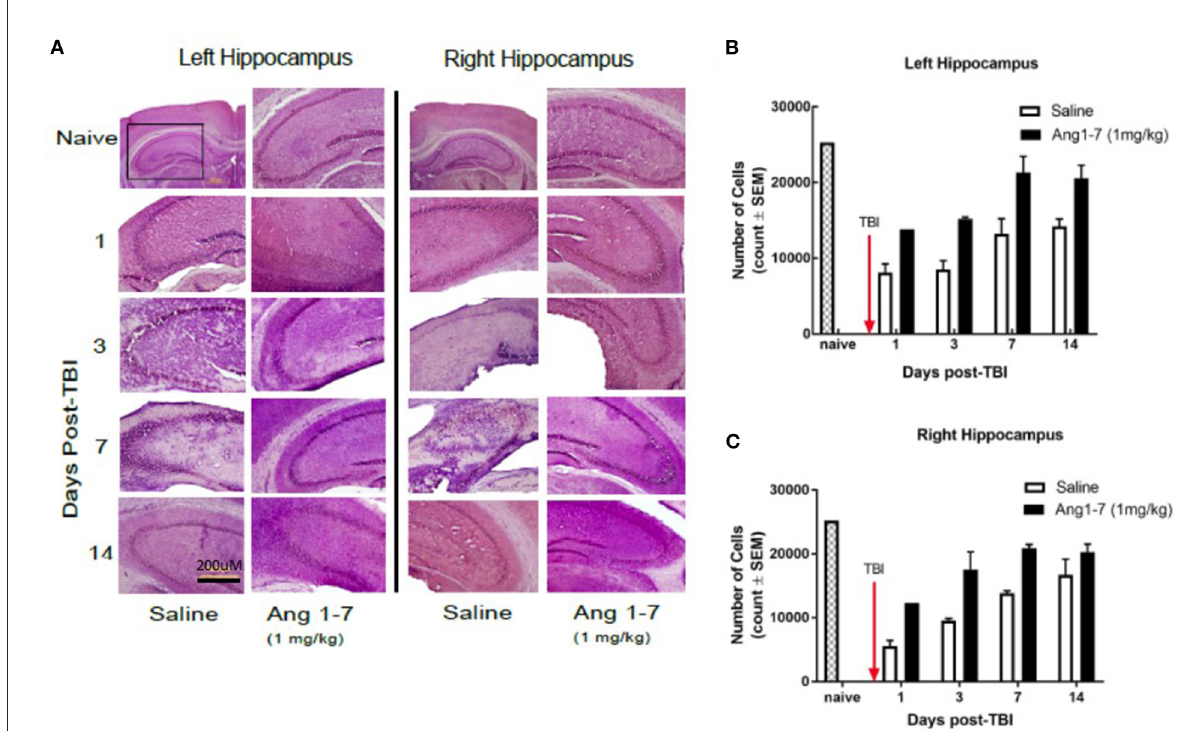
FIGURE5 Histology of hippocampus after mTBI and Ang1-7 intervention (A) HandE staining of left (ipsilateral) hippocampus and right (contralateral) hippocampus for naïve, saline ( N = 4), and Ang-(1-7) ( N = 4) (1 mg/kg, i.p./day on days 1–5) treated groups on days 1, 3, 7, and 14 post-TBI. (B) Left hippocampus shows Ang-(1-7) treated mice maintain higher hippocampal cell counts in the CA3 region compared to the saline treated mice on days 1, 3, 7, 14 post-TBI. (C) Right hippocampus shows Ang-(1-7) treated mice maintain higher hippocampal cell counts in the CA3 region compared to saline treated mice on days 1 and 3